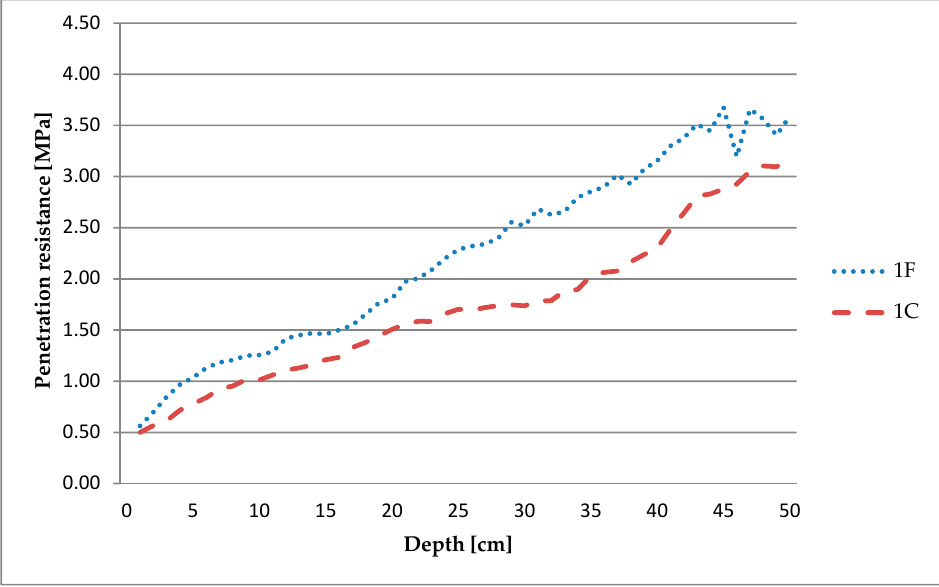
Figure 4. Soil compaction at sites 2F and 2C. At sites 1 and 2, in the entire analyzed soil profile, soil compaction in the post-fire stands was greater than in the control ones. To a depth of about 18 cm, the differences between soil penetration resistance on both sites were stable; at site 1 they amounted to about 0.2–0.3 MPa, while at site 2 they were smaller, 0.1–0.15 MPa. From a depth of 19 cm, soil compaction in the post-fire stands was significantly higher than in the control stands. The maximum difference in soil compaction at site 1, amounting to 0.94 MPa, was found at a depth of 37 cm, while at site 2 (1.83 MPa) it was a depth of 44 cm.